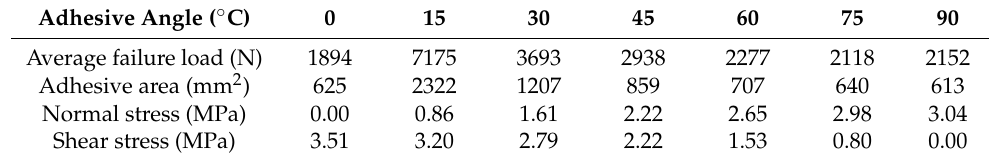
Table 5. Failure strength values of seven groups of adhesive specimens at different angles at − 20 ◦ C. Adhesive Angle ( ◦ C)